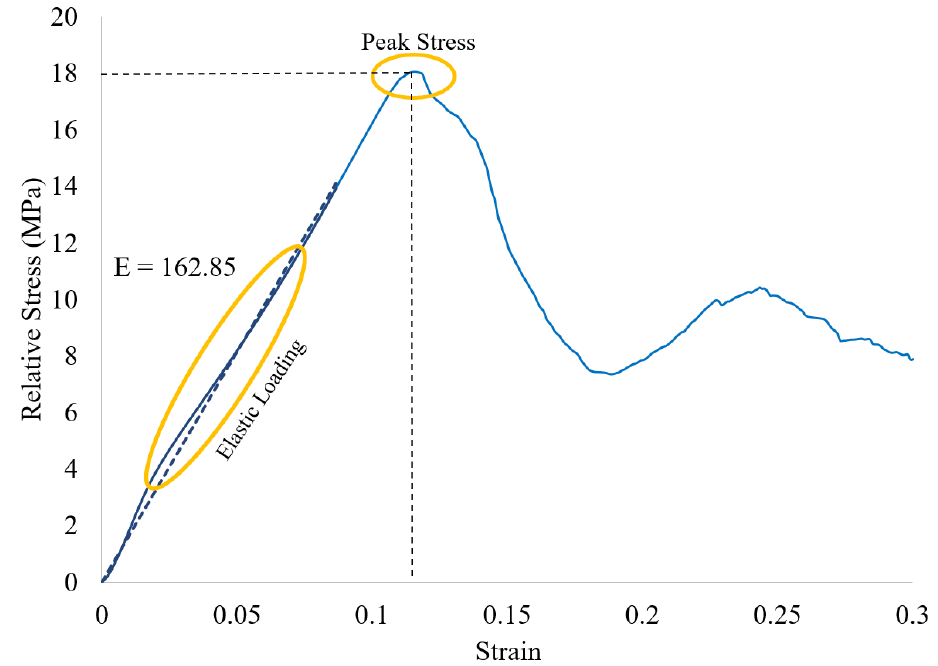
Figure 17. Relative stress–strain curve obtained for the octet truss lattice from Figure 17.